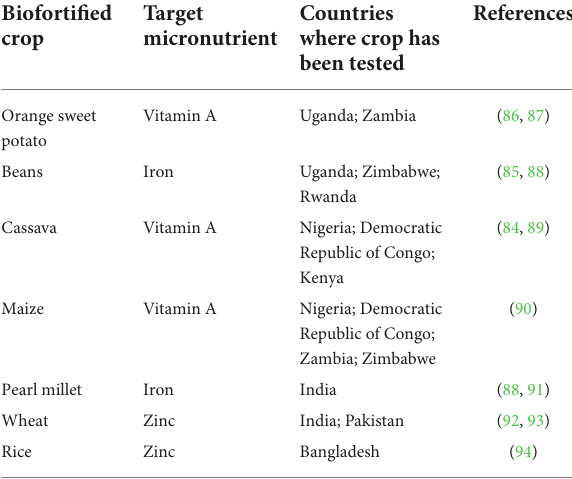
TABLE 1 Adapted biofortified crops